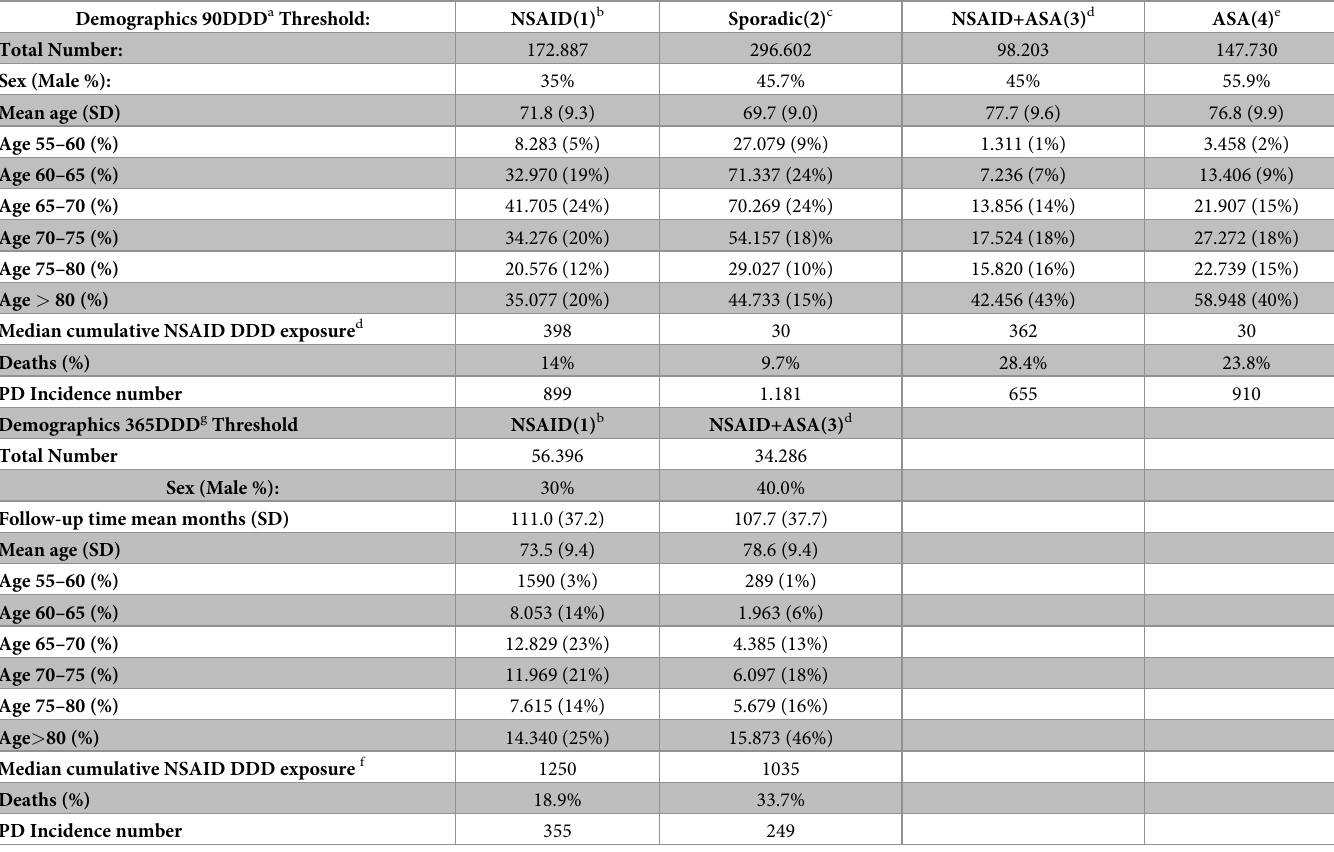
Table 2. Demographics and descriptive statistics for Norwegian Prescription Database groups used in binary logistic 5 year-lag analysis with 90 DDD a threshold.